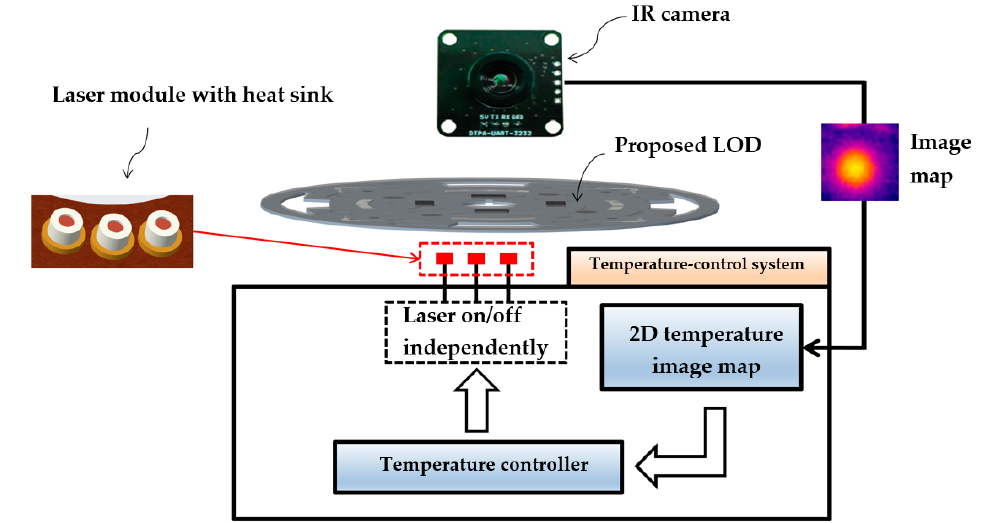
Figure 1. Temperature-control system for the amplification chamber on the lab-on-a-disc (LOD). The infrared (IR) camera provides a two-dimensional (2D) temperature map showing the distribution of the temperature in the amplification chamber. The laser module is turned on or off to keep the temperature stable.